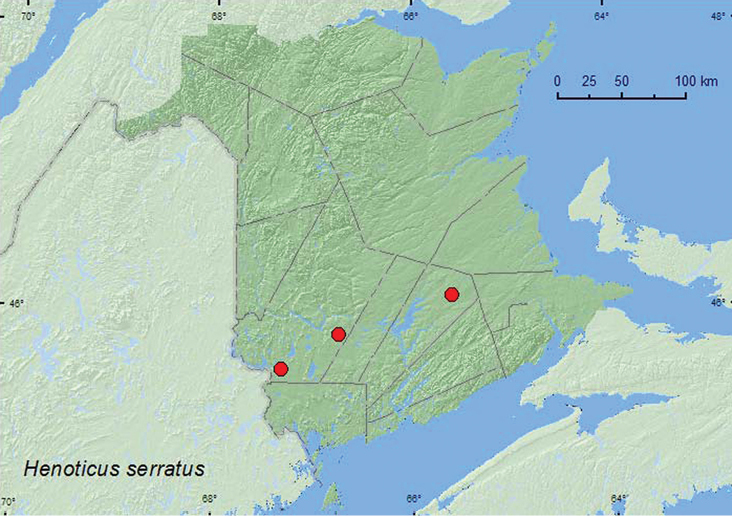
Collection localities in New Brunswick, Canada of Henoticus serratus.